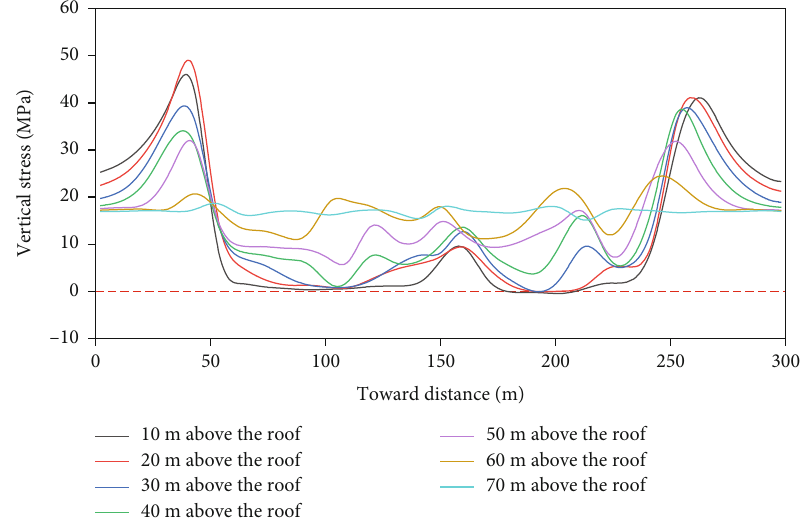
Figure 12: Distribution law of vertical stress in overlying roof strata of the No. 8 coal seam.